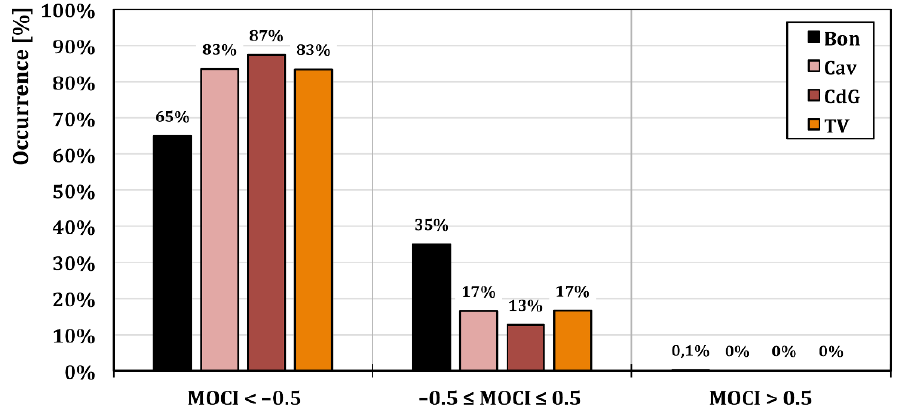
Figure 9. Occurrence of the main MOCI ranges for the four ARPA stations. Occurrences are calculated using nocturnal (from 20:00 to 05:00 LT) hourly data.